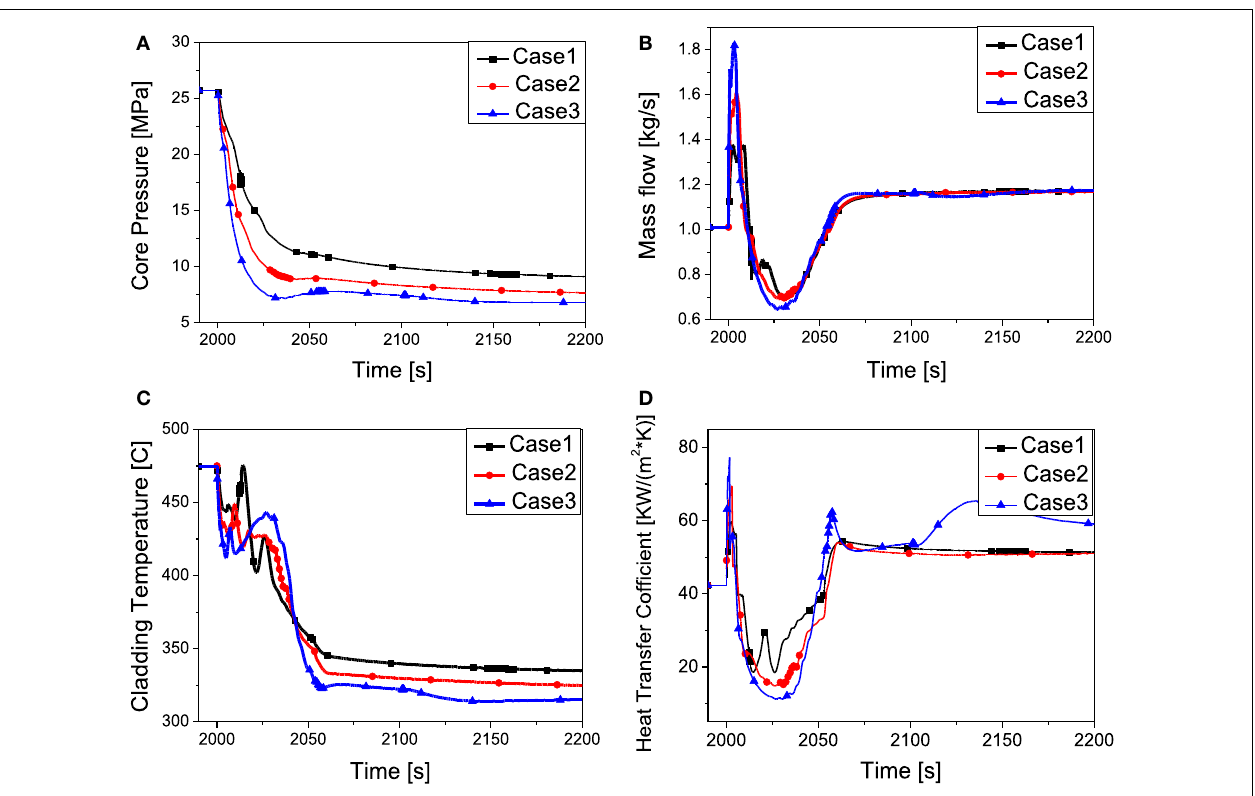
FIGURE 7 | System behavior by the effect of depressurization rate . (A) Core pressure. (B) Mass flow. (C) Peaking cladding temperature. (D) Heat transfer coefficient.